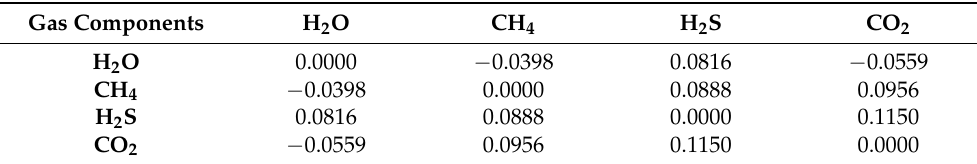
Table 1. Binary interaction parameters k ij between methane, hydrogen sulfide, carbon dioxide, and water molecules [24].